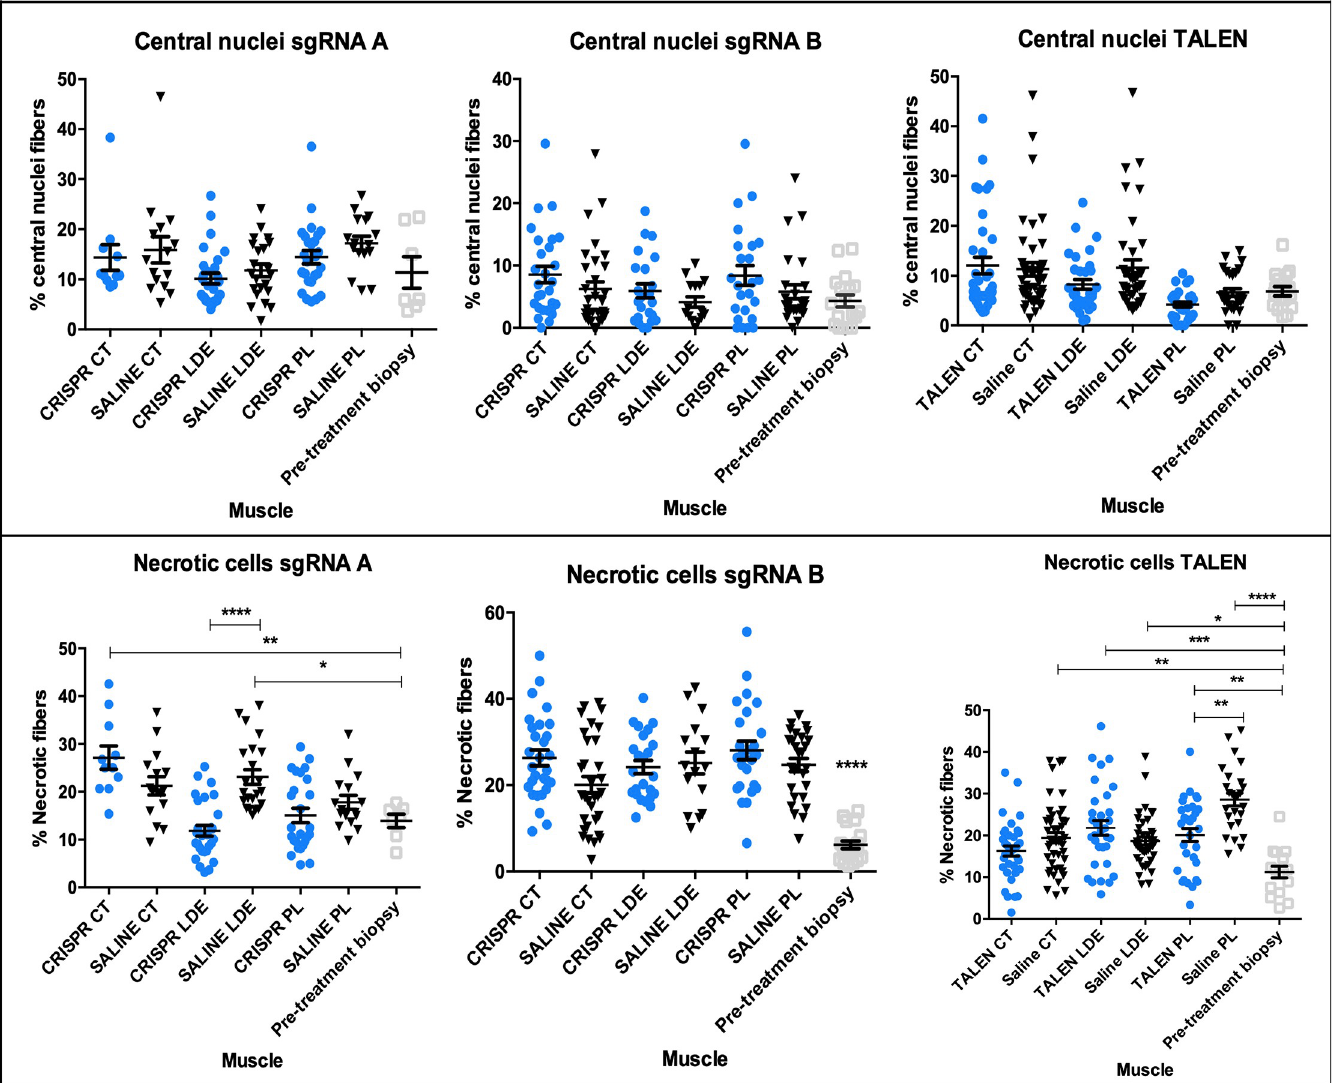
Fig 7. Percentage of central nuclei and necrosis from all three HDR treatments. Top: centrally nucleated fibers expressed as a percentage of fibers for every group treatment, sgRNA A, B and TALEN. Bottom: percentage of necrotic fibers for every treatment, sgRNA A, B (all significant versus pre-treatment biopsy) and TALEN. Blue circles denote HDR-injected limb while black triangle denotes saline-injected limb. Pre-treatment biopsy is indicated in grey square. Analysis was performed with One-way ANOVA multiple comparisons test. � p < 0.05; �� p < 0.01.; p ��� < 0.001; p ���� < 0.0001; CT = cranial tibial; LDE = long digital extensor; PL = peroneus longus.